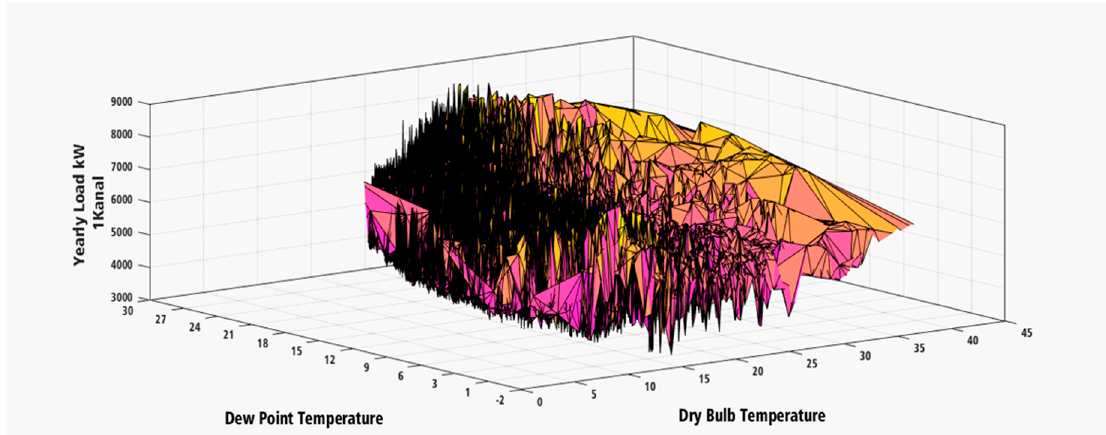
Figure 2. Load variations vs. weather